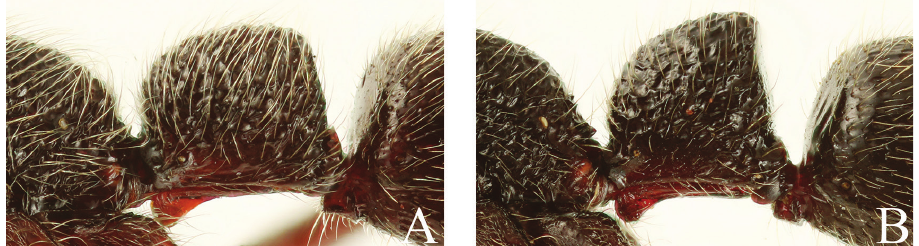
Figure 16. Petiole, lateral view. A L. breviloba B L. itoi .